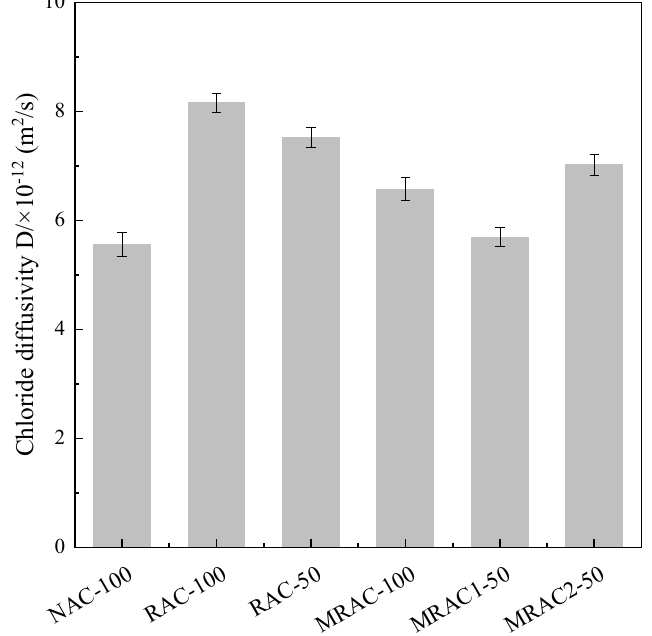
Figure 5. Chloride diffusivities of RAC at 28 days.